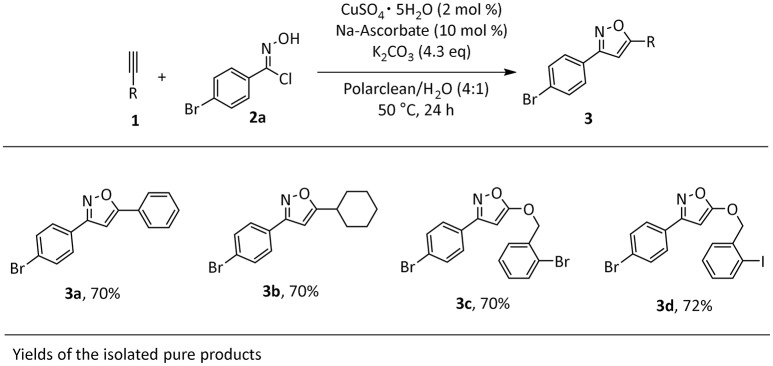
Scope of isoxazole 3a-da. aReaction conditions: 1a (1 mmol), 2a (1 mmol), CuSO4 pentahydrate (2 mol%), Na-Ascorbate (10 mol %), K2CO3 (4.3 equivalent), Polarclean/H2O (4:1) 1 M, 1mL.